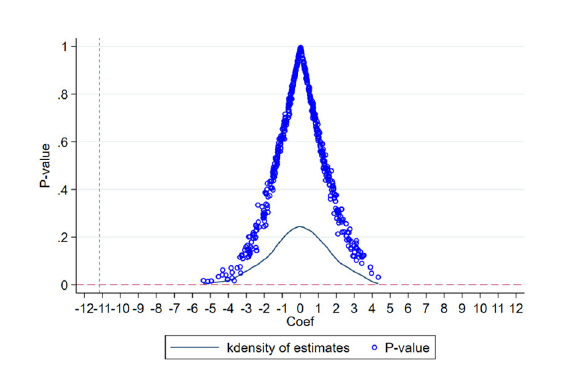
FIGURE2 Placebo test. The X-axis represents the estimated value of coefficient β _1 in equation (9). The curve is the kernel density distribution, and the dots are the p -values. The intersection of the two dashed lines is the result of the baseline